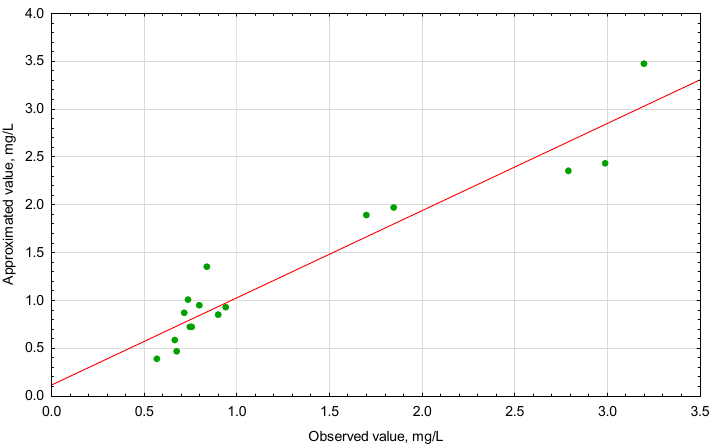
Figure 2. Approximated versus observed values plots for ∑ Cu,Cd,Zn , mg/L. The analyzed data showed a linear relationship between the observed values and the values approximated from the model. Moreover, the points reflecting the experimental data are generally randomly distributed around the estimated relationship, which proves the adequacy of the model. Figure 3A–C illustrates the response surface plots for ∑ Cu,Cd,Zn with respect to pH, Na 2 CS 3 concentration and Time.